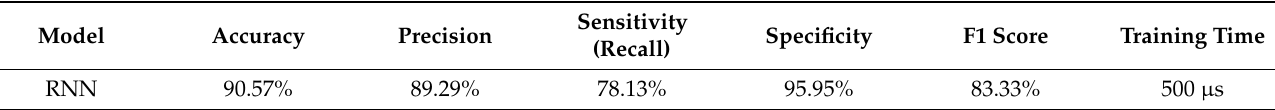
Table 11. Confusion matrix indicators: RNN.